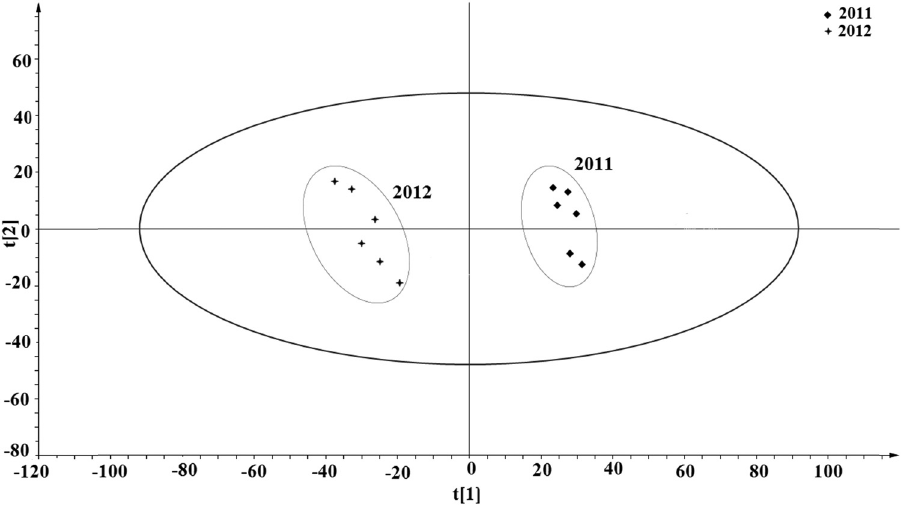
Figure 18: PLS - DA score plot chart from 1 H NMR spectra of 2011 and 2012 vintage Cabernet Sauvignon